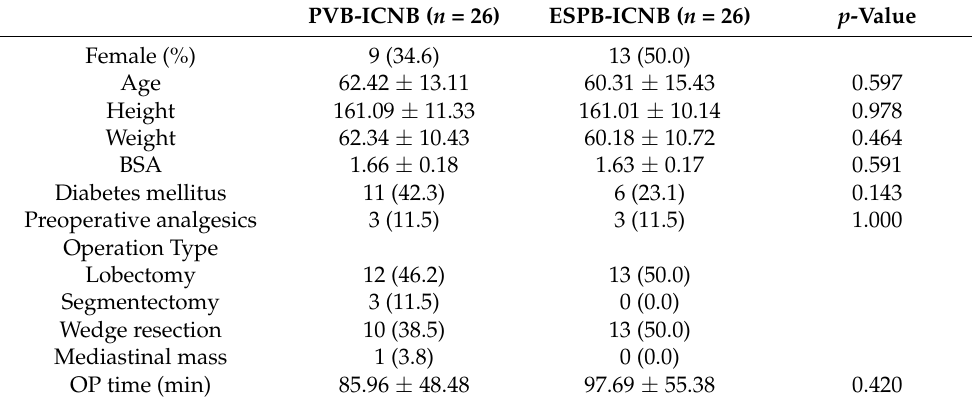
Table 1. Patient characteristics and surgery